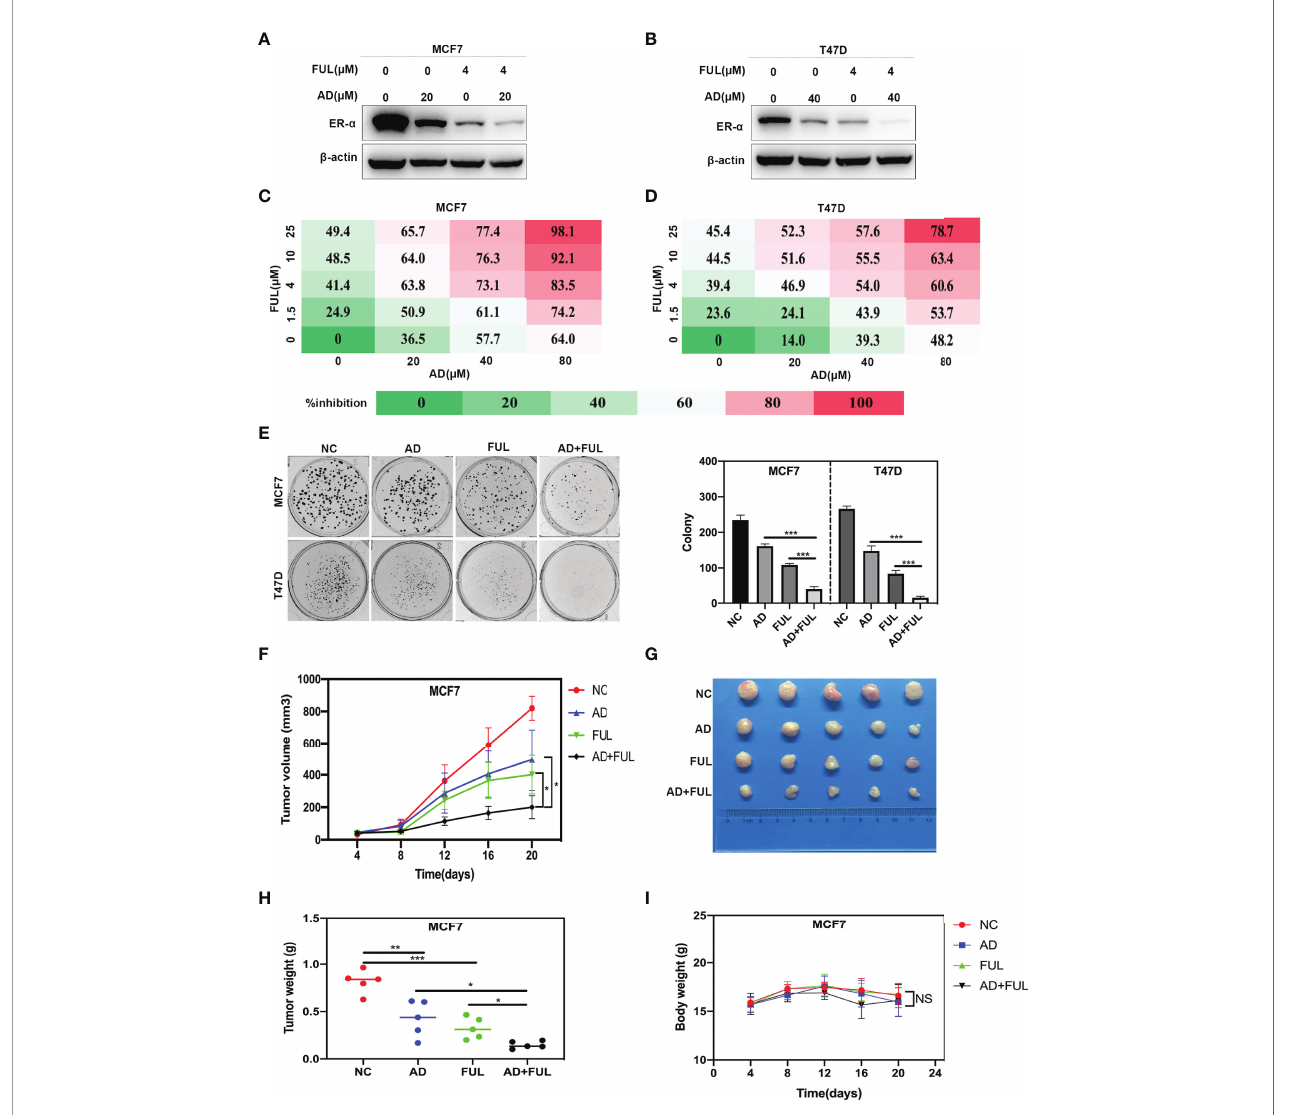
FIGURE 5 | AD synergizes with fulvestrant to inhibit ER- a expression and breast cancer growth. (A, B) MCF7 and T47D cells were treated with AD and/or fulvestrant for 24 h and harvested for Western blotting with antibodies against ER- a and b -actin. (C, D) MCF7 and T47D cells were treated with escalating doses of either AD or fulvestrant for 72 h, followed by analyzing the cell proliferation rate assessed by ATPlite luminescence assay. Percent inhibition at each dose of drug is presented. (E) MCF7 and T47D cells were treated with AD (10 m M) and/or fulvestrant (0.1 m M) for 2 weeks, followed by analyzing the cell colony formation. (F – I) Nude mice bearing breast cancer xenografts with MCF7 cells were administered with 20% HPBCD, AD (150 mg/kg per day), fulvestrant (5 mg/mouse administered subcutaneously, once per week) and AD plus fulvestrant. The treatments for the nude mice were carried out on 4 days after MCF7 cells injected and lasted for 16 days. (F) Tumor volumes were determined by caliper measurement, and the data was converted to tumor growth curve. (G) Images of the tumors in each of the 4 groups at the end of experiment. (H) Weight of the tumors in each of the 4 groups was measured with an electronic scale immediately after the tumor was collected. (I) The mice weights were recorded every 4 days during the whole experiment. (Data were presented as mean ± SD. *P < 0.05, **P < 0.01, ***P < 0.001, NS denotes not signi fi